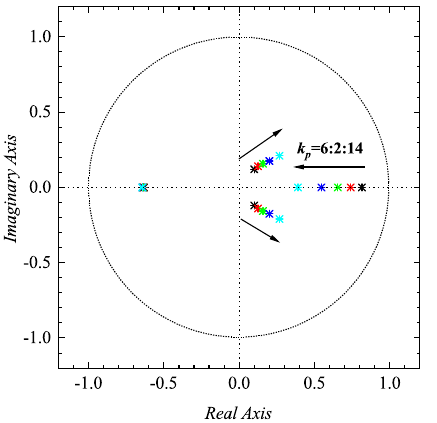
Figure 9. The pole location of G p ( z ) when k p _ RC changes.